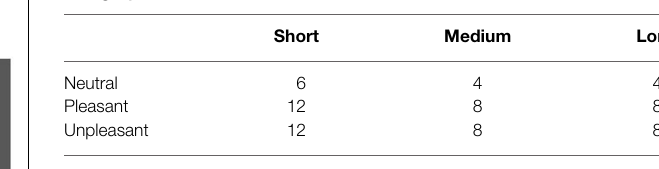
TABLE 2 | Number of trials per participant for each Duration (cid:2) Emotion category